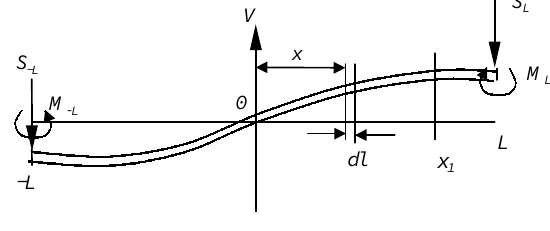
Fig. 1. Deflected form of a simple beam.